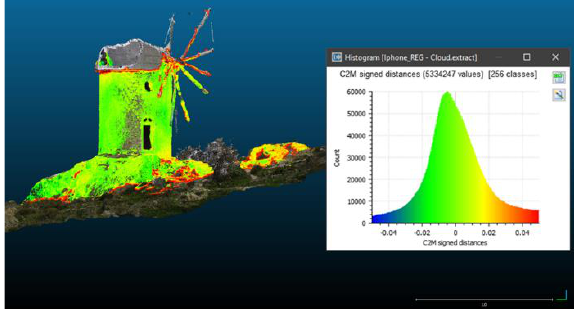
Figure 9. C2M distance analysis between 3D